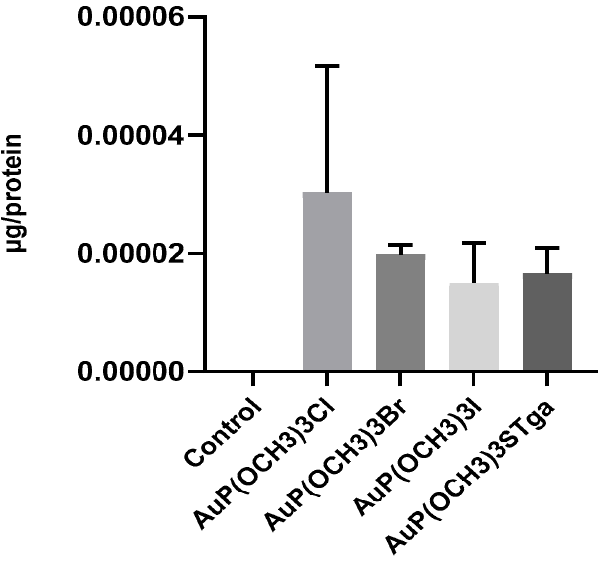
Figure 5. Analysis of gold content in A2780 cells following treatment; the gold content is indicated as a ratio between μ g of gold and total protein amount. Histograms report the mean values ±SD.